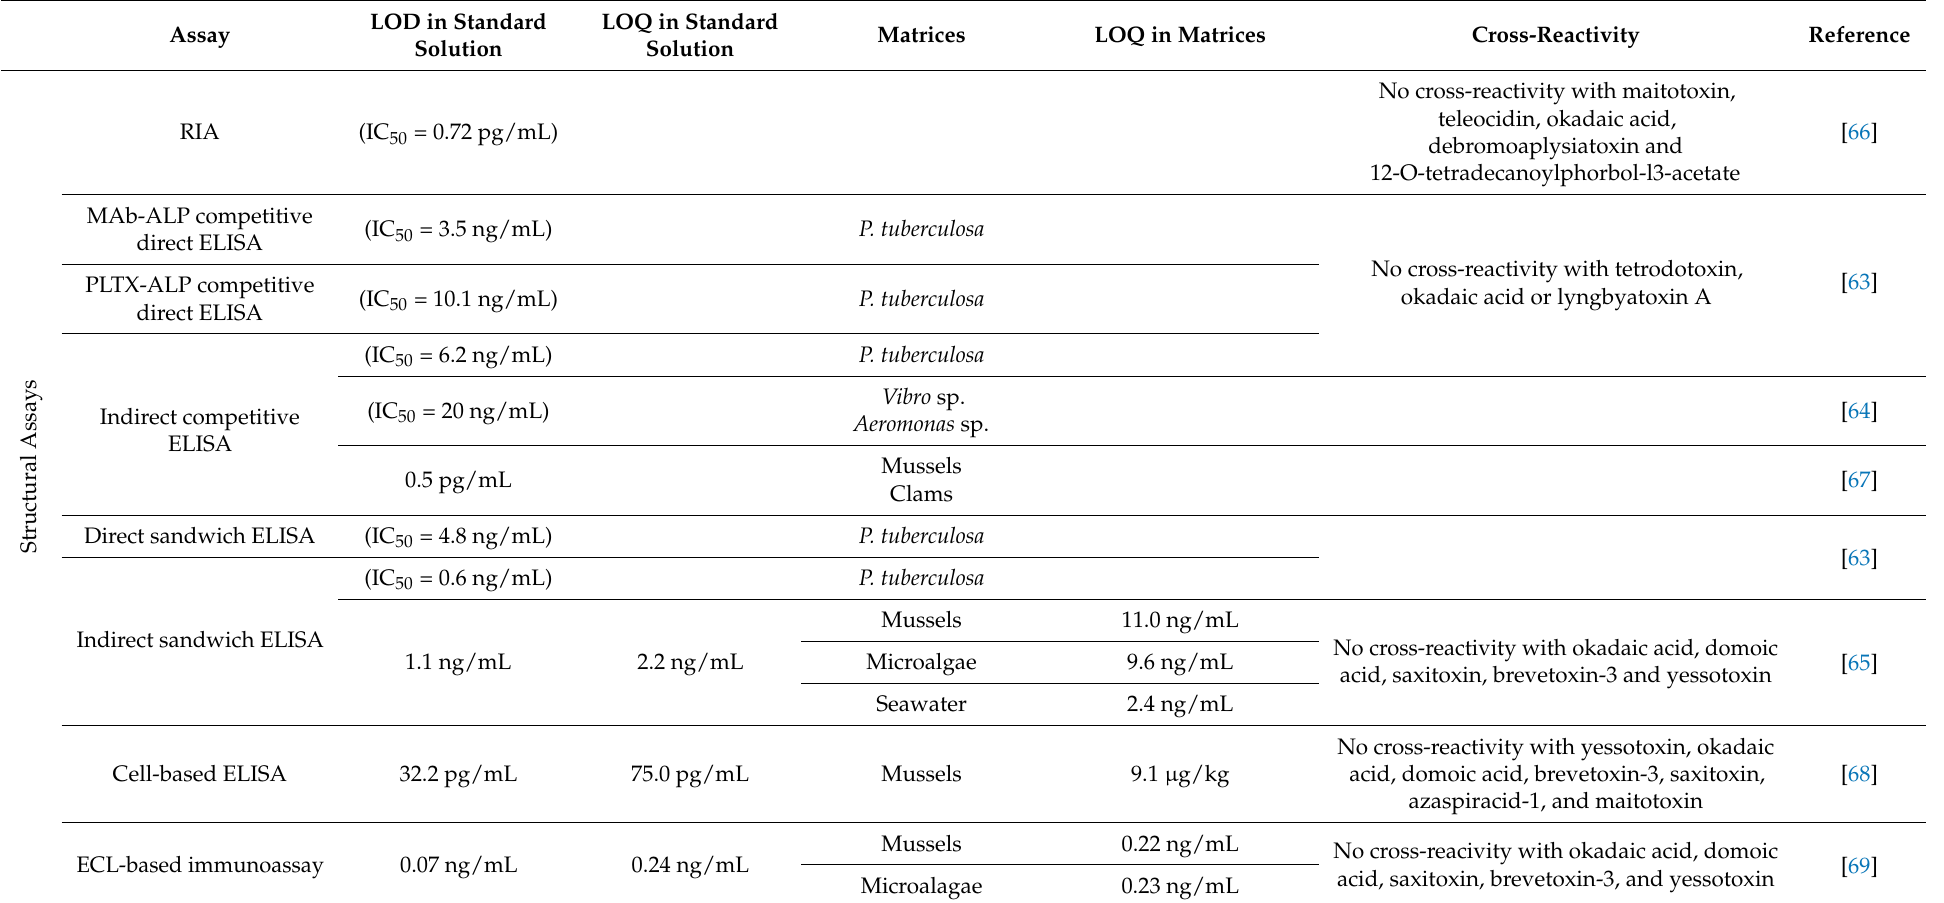
Table 2. Structural assays for PLTX